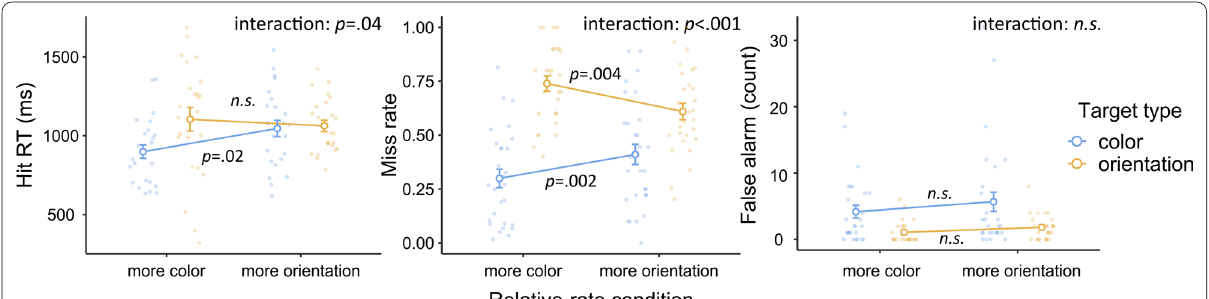
Fig. 4 Experiment 2 results. Note In Experiment 2, relative target-rate effects occurred mainly in terms of miss rates, such that the relative-rate conditions significantly modulated the performance of detecting each type of target. The same target type was missed more when it was relatively rare. There was a similar relative target-rate effect in terms of hit RTs, but the effect was more visible with color targets. Error bars represent standard error of the